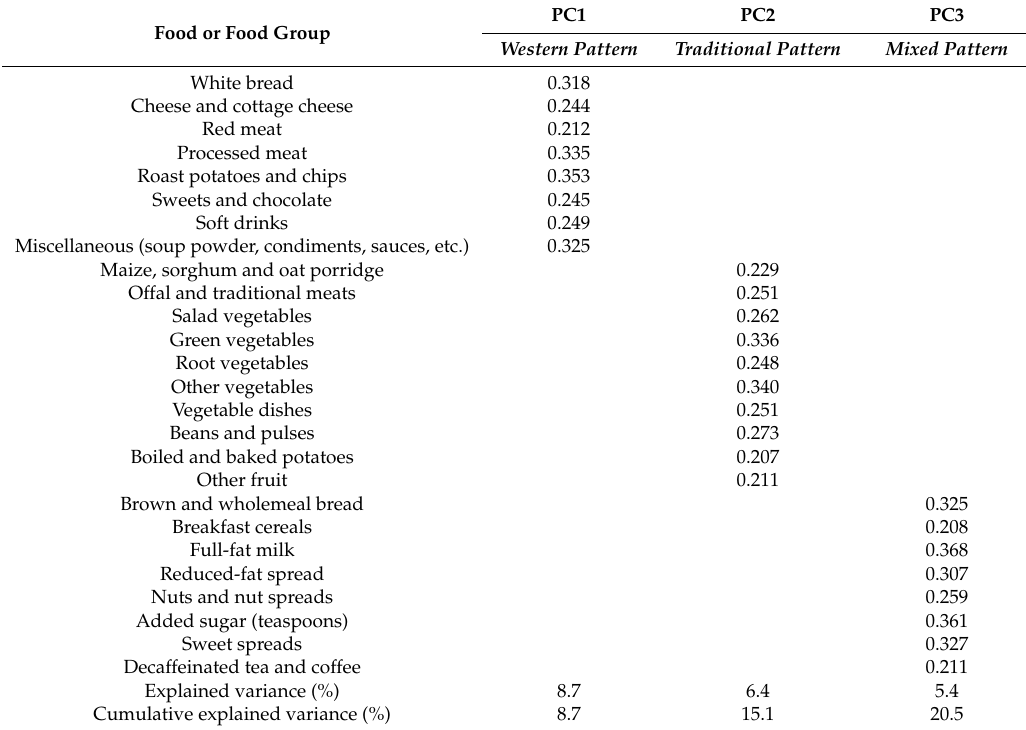
Table 2. Factor loadings of various foods or food groups characteristic to the principal dietary components identified in pregnant South African women ( n =